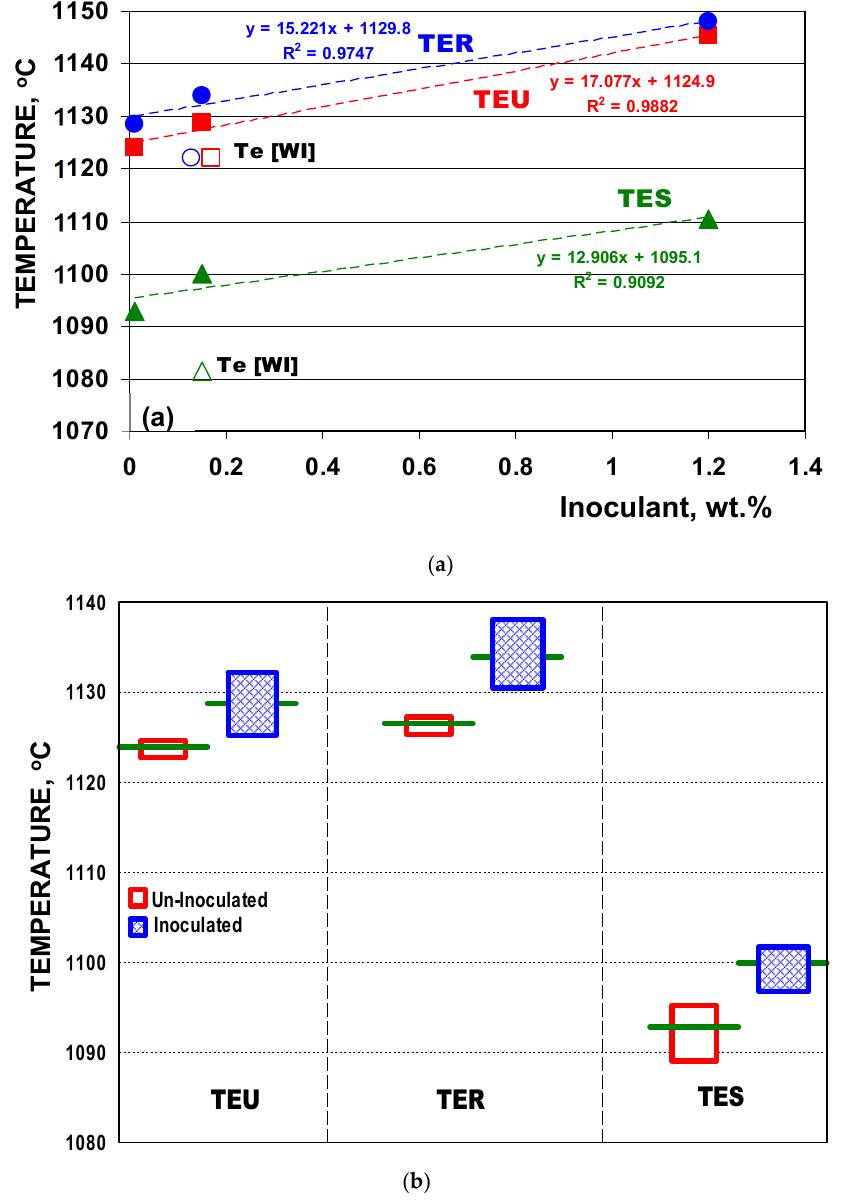
Figure 4. The lowest (TEU) and the highest (recalescence) (TER) temperatures of eutectic reaction and of the end of solidification (TES) (influence of metallurgical treatments, as average values ( a ) and the range and average values ( b ) of un-and-normal inoculated irons (0.15/wt.% alloy), WI—White (carbidic) iron).